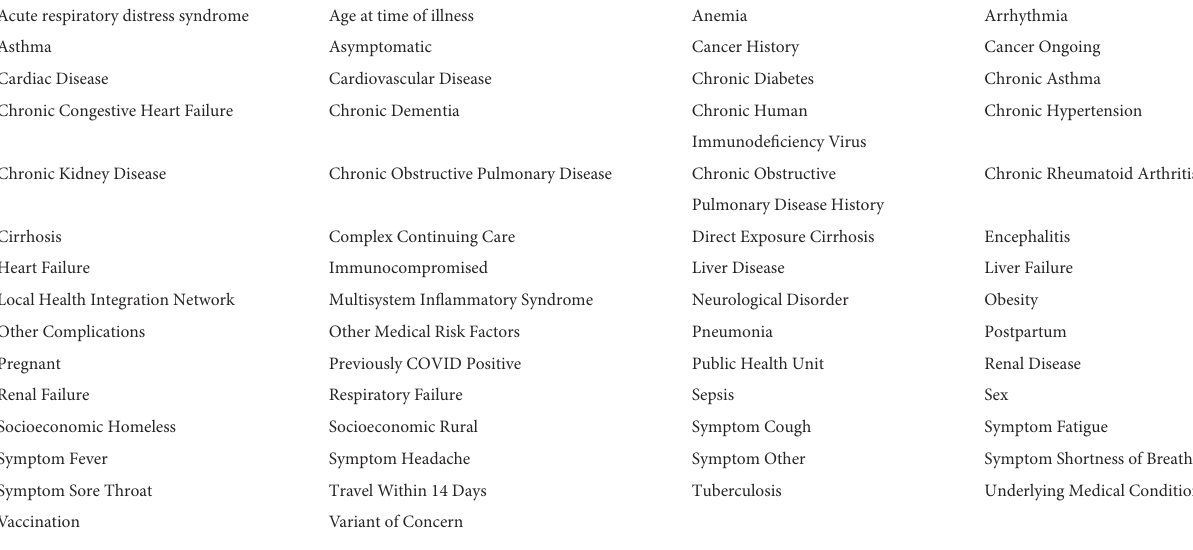
TABLE 1 Master list of patient features, prior to filtering, and hyperparameter